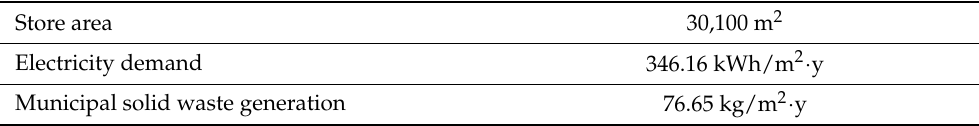
Table 1. Medium size mall. Specification.